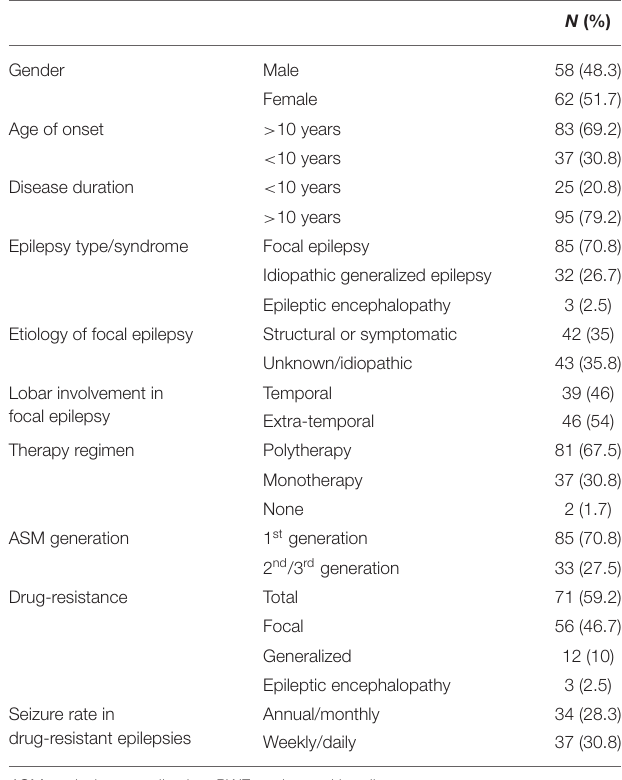
TABLE 1 | Demographic and clinical characteristics of PWE enrolled in the study ( N =